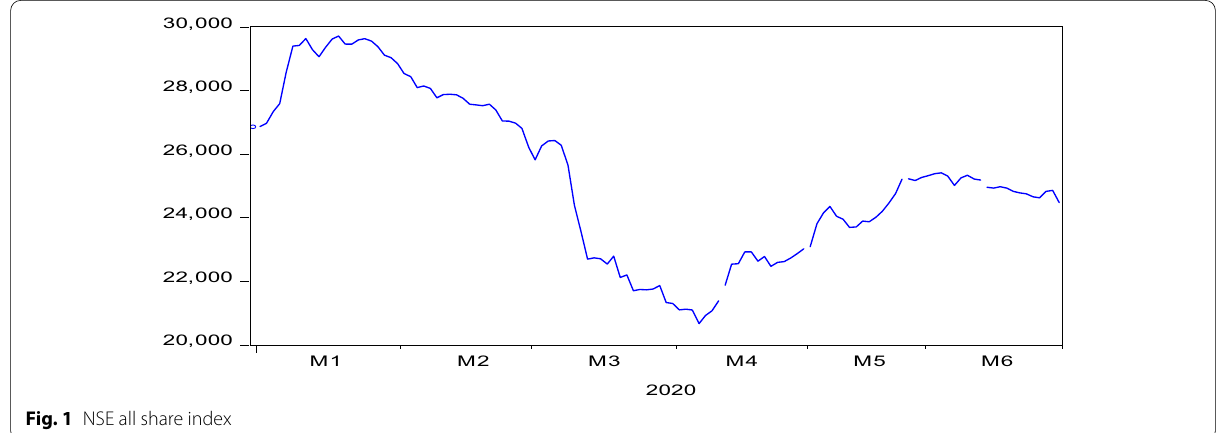
Fig. 1 NSE all share